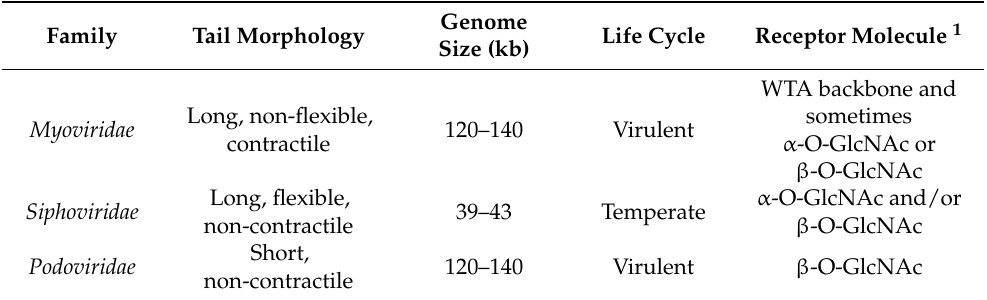
Table 1. Summary of the main characteristics of the three phage families that infect staphylococci. Family Tail Morphology